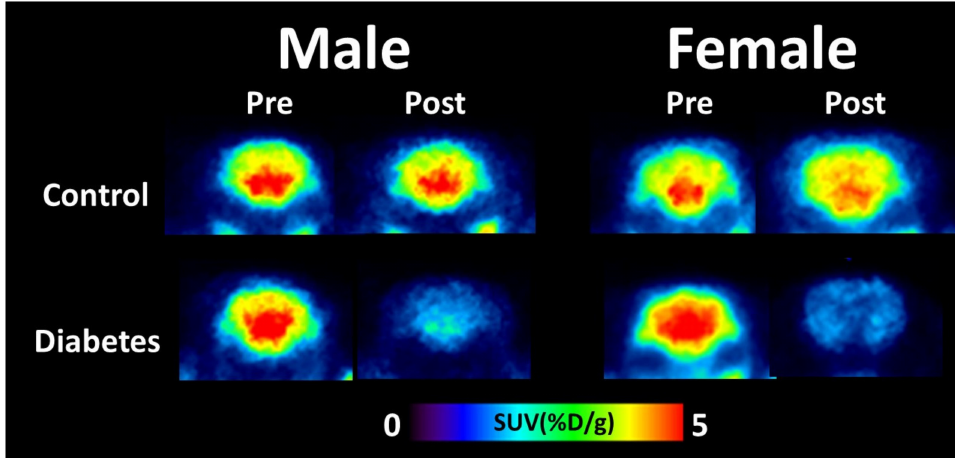
Figure 2. Representative positron emission tomography images of cerebral 18 F-fluorodeoxyglucose uptake for control and diabetes groups between sexes. SUV, standardized uptake